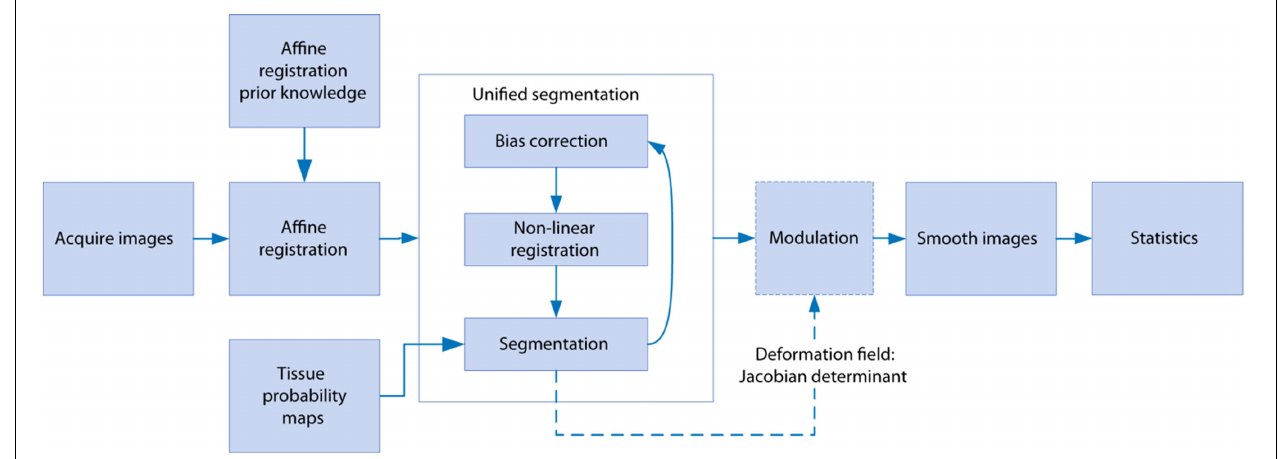
FIGURE 1 | The steps involved in the voxel-based morphometry study. After image acquisition, affine registration adjusts the images to control for different head positions and scanner geometry as well as overall brain size. Unified segmentation iteratively warps the data whilst correcting for signal inhomogeneity due to the receiver coil and classifies each voxel as gray